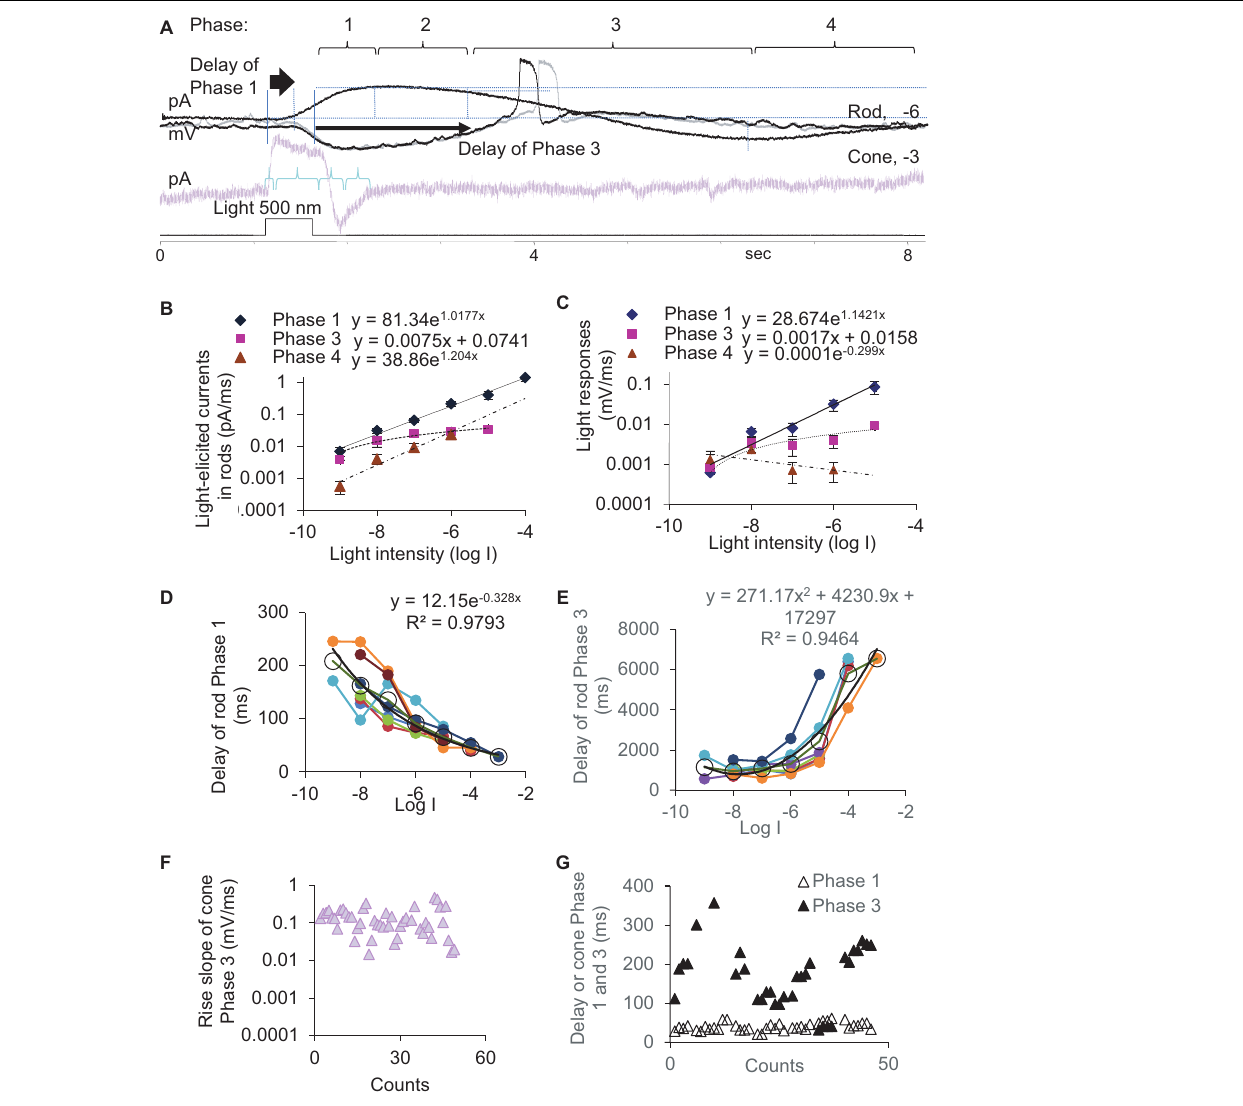
FIGURE 2 | Kinetics and latency of the light response of photoreceptors. (A) The light-evoked current of rods and cones are described by Phase 1–4. Rods (A–E) or cones (F,G) were recorded under whole-cell voltage- ( A,B,D,E,G , Vh = –40 mV) and current-clamp modes (A,C,F) . (B,C) The slope of light-evoked graded currents (B) and potentials (C) was exponentially correlated with light intensity in Phase 1 (diamond, p < 0.0001 and p = 0.001, respectively) and Phase 4 (triangle, p = 0.021 and p = 0.416, respectively) and linearly correlated with light intensity in Phase 3 (square, p = 0.004 and p = 0.041, respectively). (D,E) In rods, the delay time of Phase 1 (D) and Phase 3 (E) are exponentially negatively and positively correlated with the light intensity (log I), respectively (both p < 0.0001). Black circles and lines display the averaged delay (mean, SEM) and the fitting curve of data from individual rods (color dots and lines), respectively. (F,G) Light-evoked potentials (F) and currents (G) at –3 and –4 log I in cones. (F) Phase 3 slope of cones is ∼ 10 times faster than that of rods (C) . (G) The cone Phase 3 delays ∼ 10 times shorter than that of the rod Phase 3 (E) , while the delay of Phase 1 under photopic light is similar for rods (D) and cones. Vh-holding potential. The intensity of unattenuated [0 in log unit (log I)] 500 nm light from a halogen light source was 4.4 × 10 5 photons. µ m − 2 .s − 1